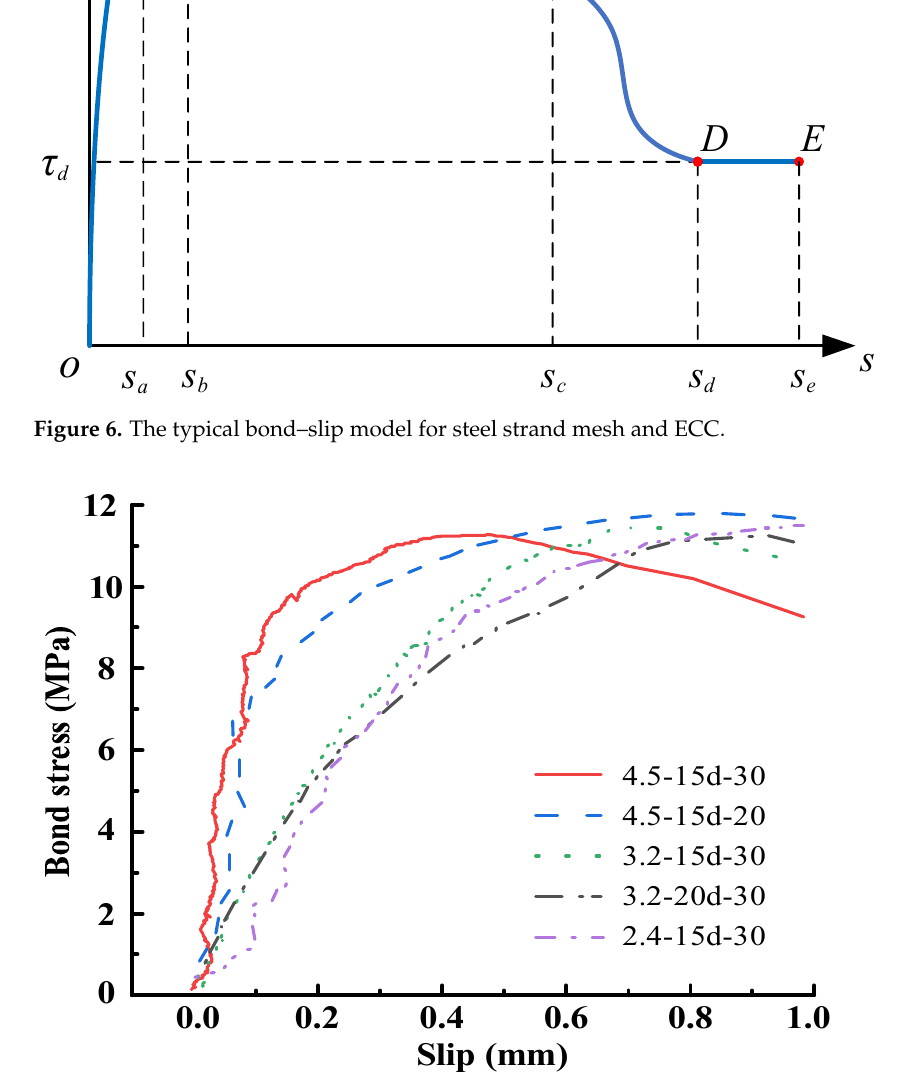
Figure 7. Bond slip curves in upward stage.